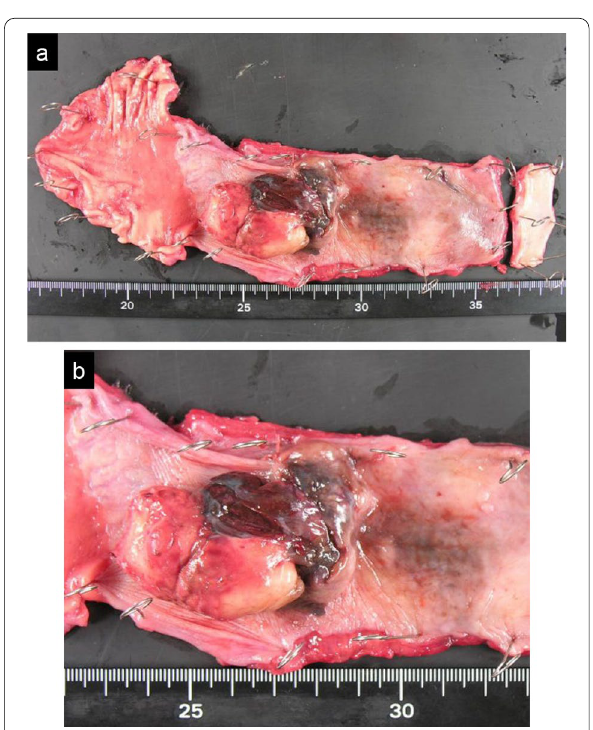
Fig. 1 a Resected specimen after thoracoscopic subtotal esophagectomy. b Magnified view of the same specimen described in a . An elevated black mass is found in the